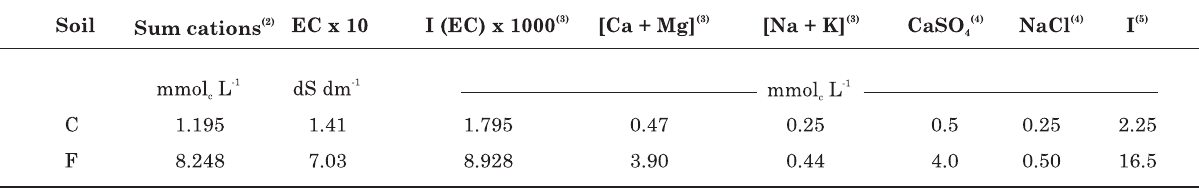
(1) Data represent mean value of three samples. (2) Sum of the concentrations of the major mono- and divalent cations (Ca + Mg + Na + K) in the extract analysis. This value must match the electrolytic conductivity (EC) value (dS dm -1 ). 20 . (3) Estimated ionic strength calculated from the EC (dS m -1 ), by multiplying this value by the constant 0.0127. 19 . (4) The CaSO determined for the background solution of the subsequent experiments. (5) Ionic strength calculated from the CaSO